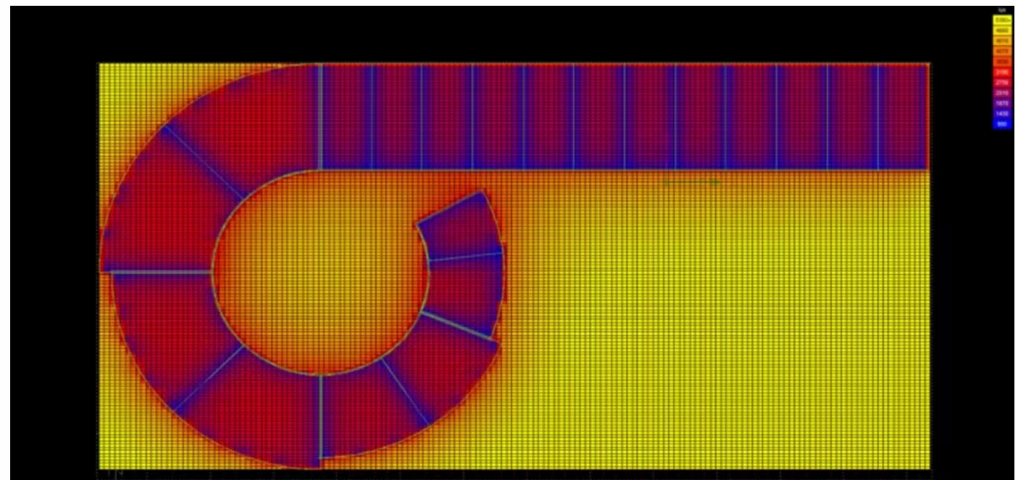
Figure 27. Daylighting